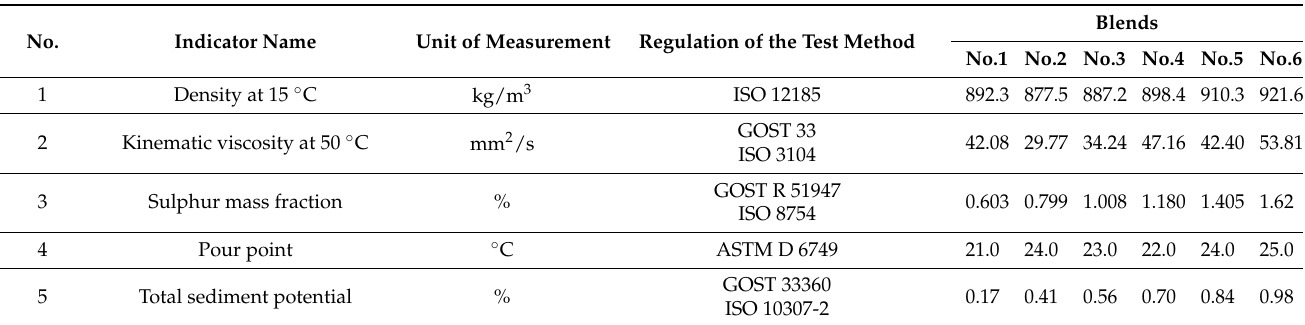
Table 3. Quality indicators of the obtained fuel mixtures.